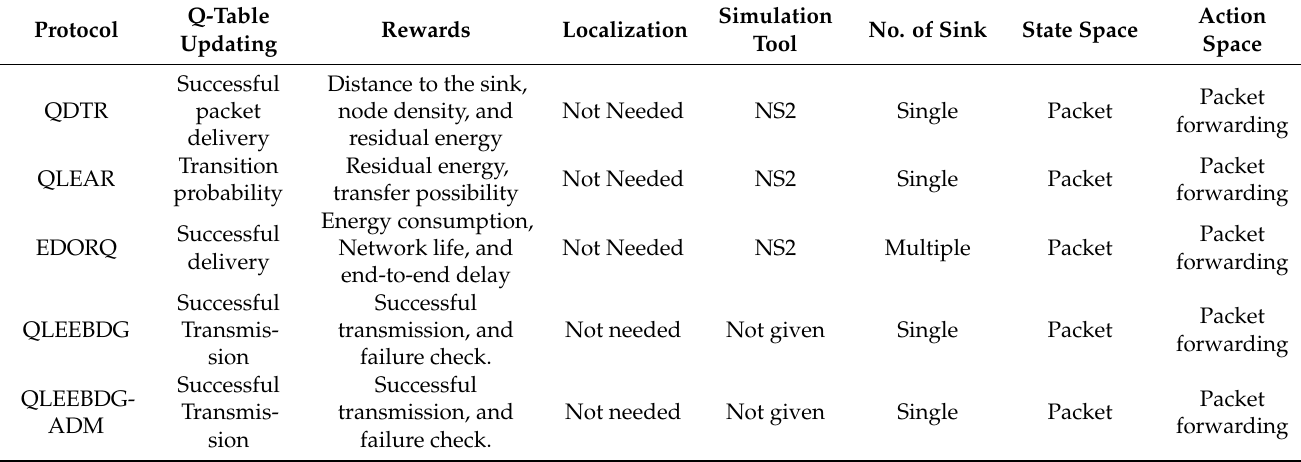
Table 7. Comparison of RL-based